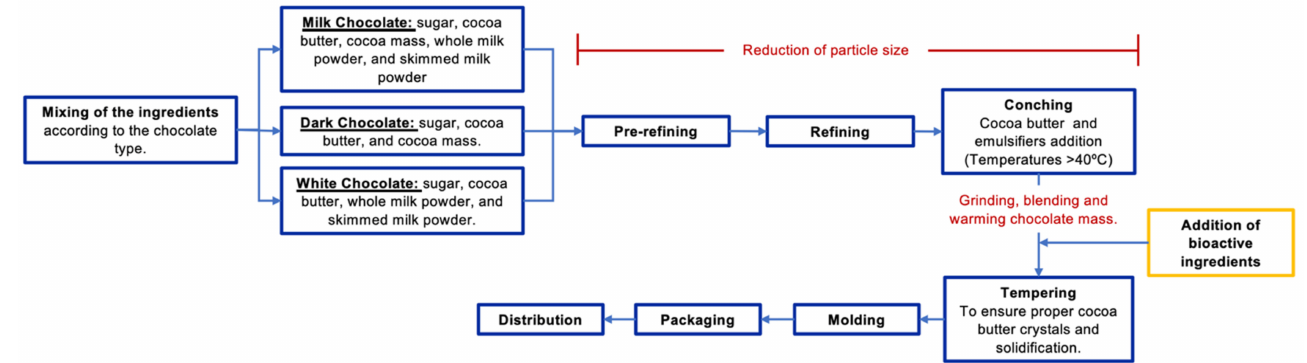
Figure 1. General bioprocess to obtain functional chocolates added with bioactive ingredients. Bioactive ingredients are added at the beginning of the tempering process to minimize degradation of chemical compounds induced by temperature during conching, and to preserve the viability of probiotic bacteria